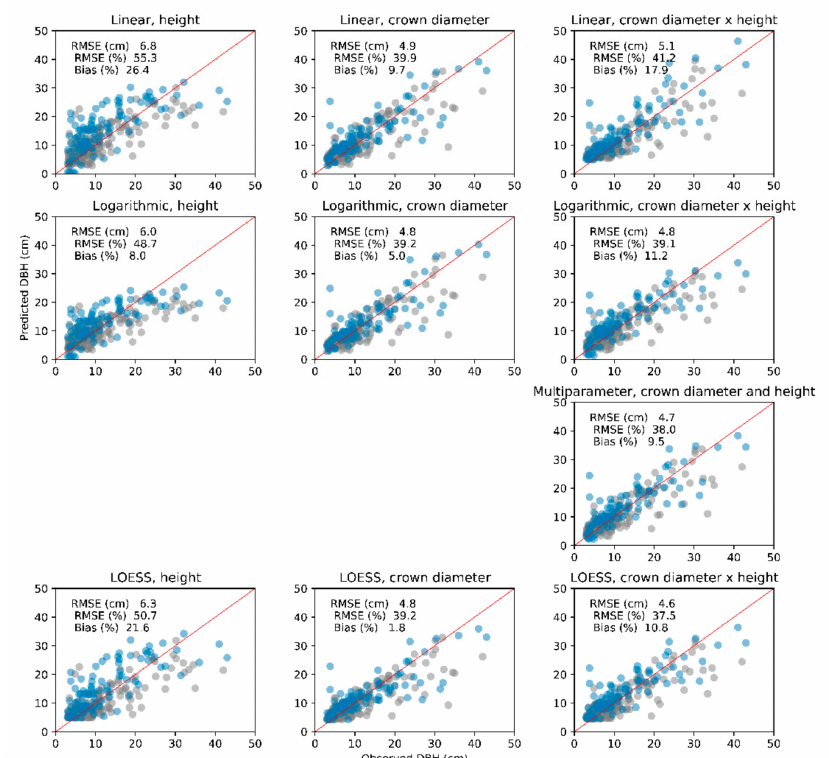
Figure 4. Scatter plots showing the relationship between DBH measured in field-surveys and DBH predicted using crown height, diameter, and height multiplied by crown diameter (HCD). Grey points represent the calibration dataset and blue points represent the validation dataset. RMSE and bias values relate to the validation dataset. The red line represents a 1:1 relationship between predicted and observed values.